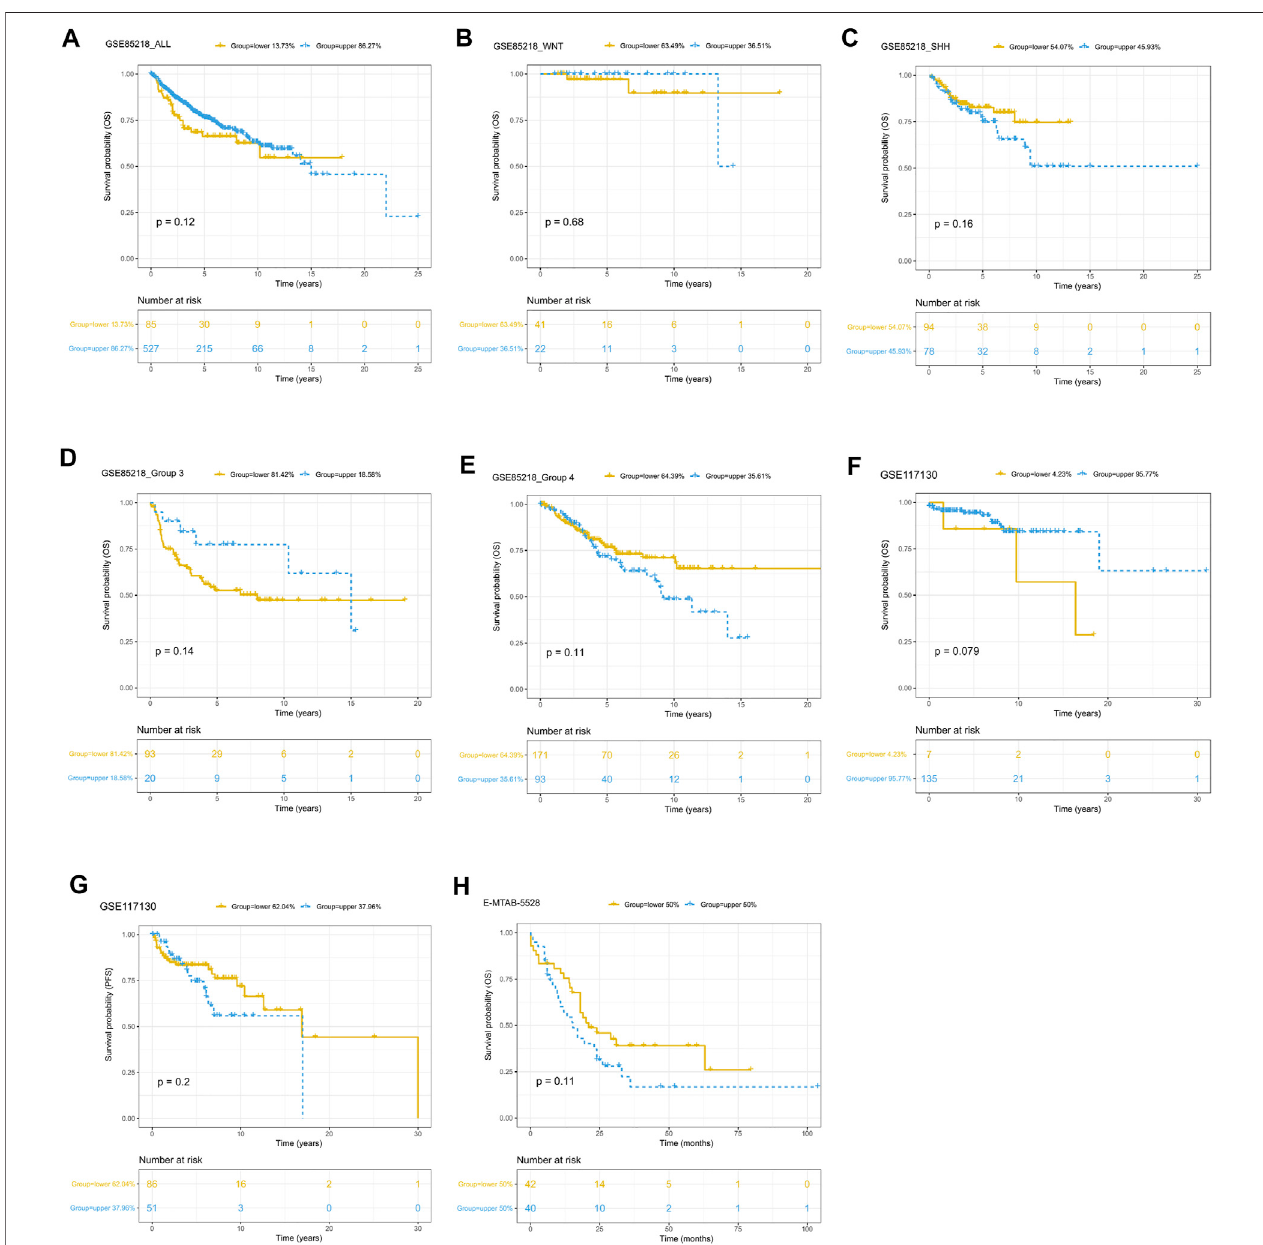
FIGURE 10 | Prognostic role of tumor purity in three pediatric CNS tumor datasets. (A) Kaplan – Meier (K-M) curves for overall survival according to tumor purity in the GSE85218 dataset; (B) K-M curves for overall survival according to tumor purity of the WNT subgroup medulloblastoma (MB) in the GSE85218 dataset; (C) K-M curves for overall survival according to the tumor purity of the SHH subgroup MB in the GSE85218 dataset; (D) K-M curves for overall survival according to the tumor purity of Group 3 subgroup MB in the GSE85218 dataset; (E) K-M curves for overall survival according to the tumor purity of Group 4 subgroup MB in the GSE85218dataset; (F) K-McurvesforoverallsurvivalaccordingtothetumorpurityintheGSE117130dataset; (G) K-Mcurvesforprogression-freesurvivalaccordingto the tumor purity in the GSE117130 dataset; (H) K-M curves for overall survival according to the tumor purity in the E-MTAB-5528 dataset.